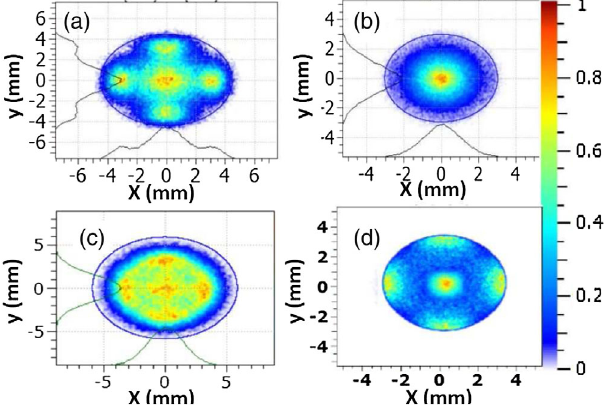
FIG. 10. Initial distribution of the lost particles for the (a) Gaussian, and (b) HOMB, with zero initial mismatch, and for the (c) Gaussian and (d) HOMB, with 30%